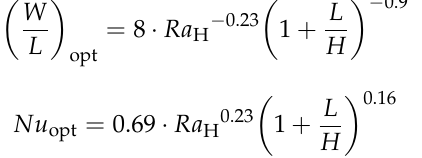
where the former has a 2.4% standard deviation of error and the latter with a 1.9% standard deviation of error, as shown in Figures 13 and 14, respectively.